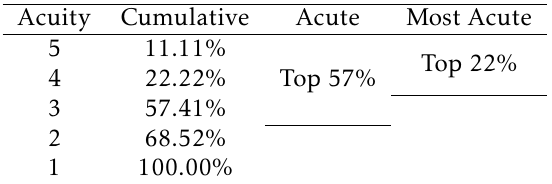
Table 1. Definitions of acute and most acute. We chose the category ranges that came closest to the top 25% and 50% to define these terms.